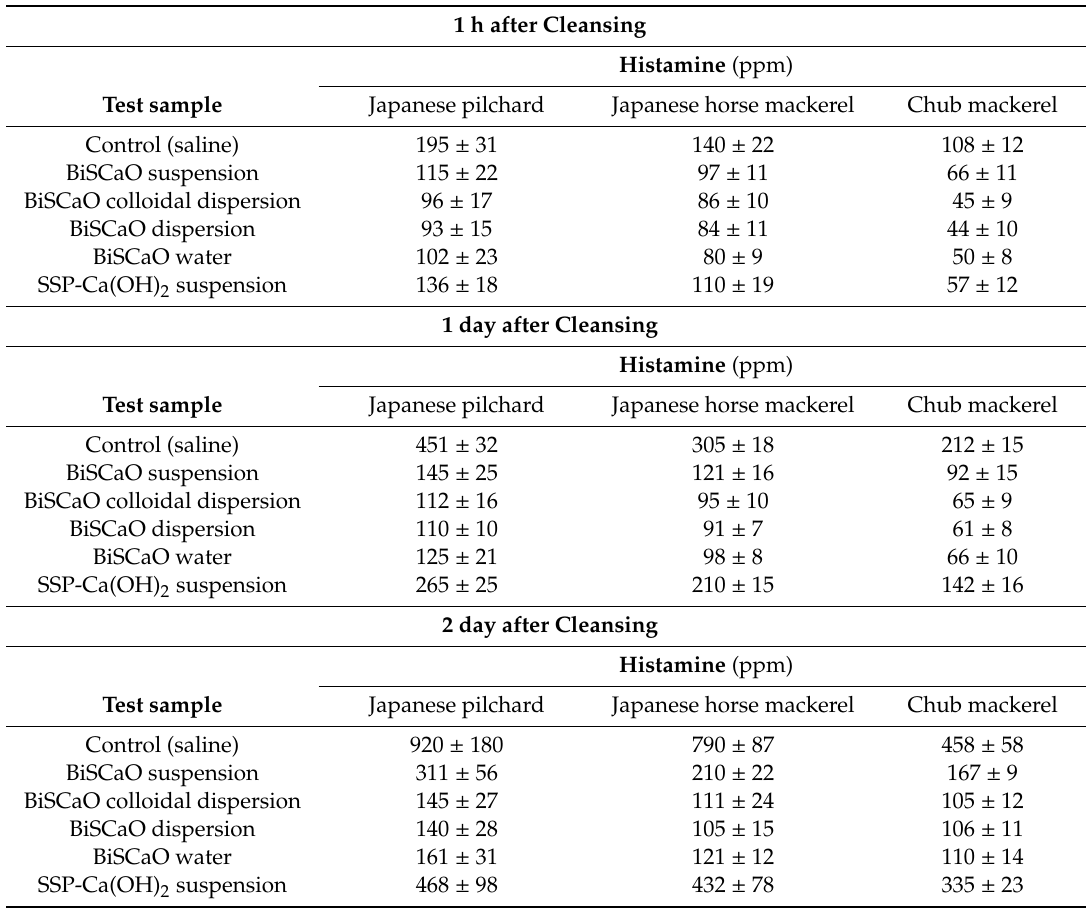
Table 4. Reduction of histamine in pre-incubated Japanese pilchard, Japanese horse mackerel, and chub mackerel samples by cleaning with various BiSCaO-based disinfectants ( n =